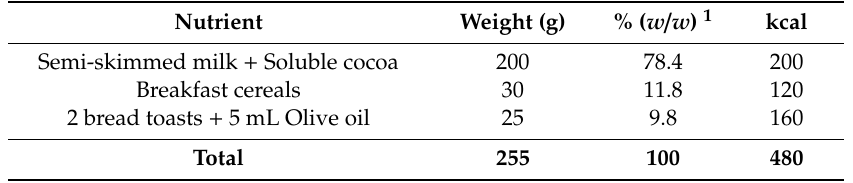
Table 1. Nutrients of the standardized breakfast included in the Teavigo ® plus breakfast intervention. Nutrient Weight (g) % ( w / w ) 1 kcal Semi-skimmed milk + Soluble cocoa 200 78.4 200 Breakfast cereals 30 11.8 120 2 bread toasts + 5 mL Olive oil 25 9.8 160 Total 255 100 480 1 w =